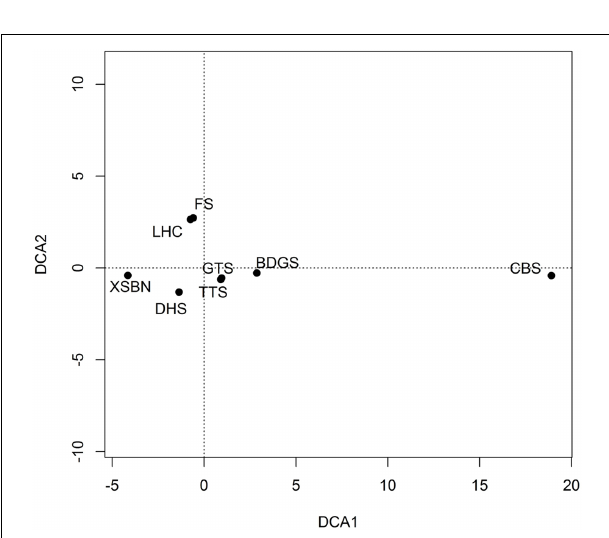
FIGURE 3 | DCA analysis of plant species composition among eight dynamics plots. The plot codes are the same as in Figure 2 .